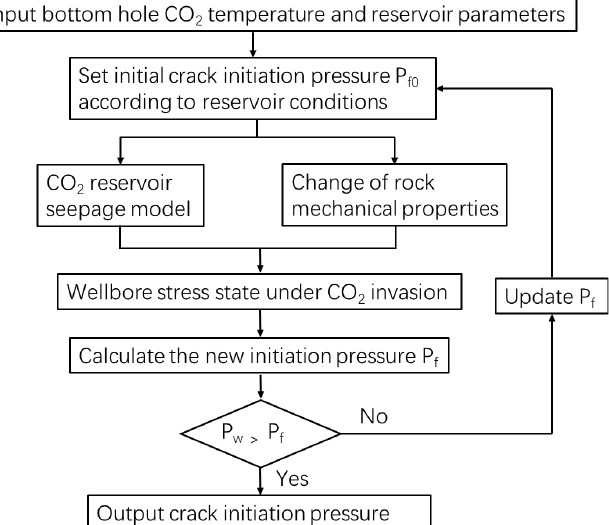
Figure 1. Coupling calculation process. Table 1. Basic